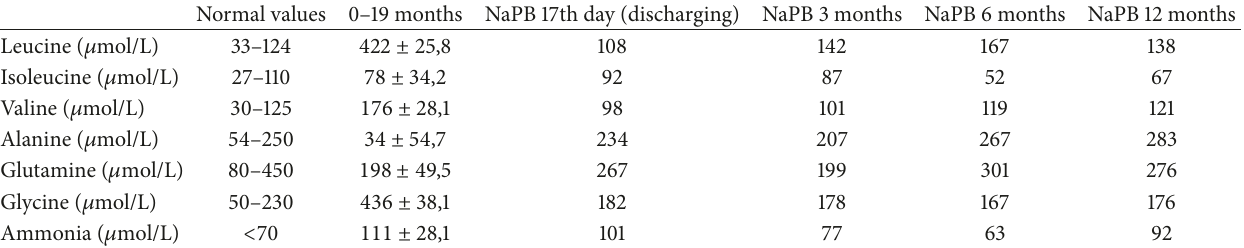
Table 1: Values of plasma leucine, isoleucine, valine, alanine, glutamine, glycine, and ammonia during periods of therapy.